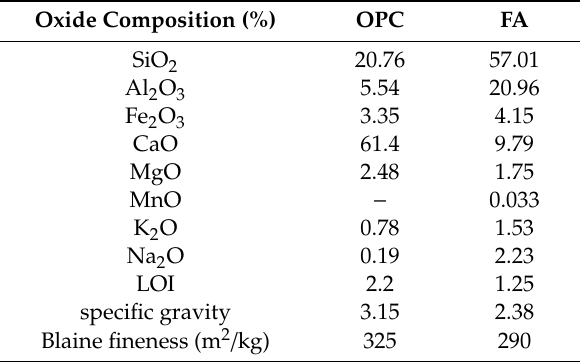
Table 1. Oxides and properties of OPC and FA.